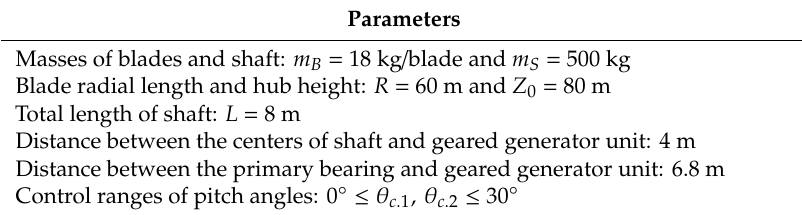
Table 1. System parameters for the numerical simulations.